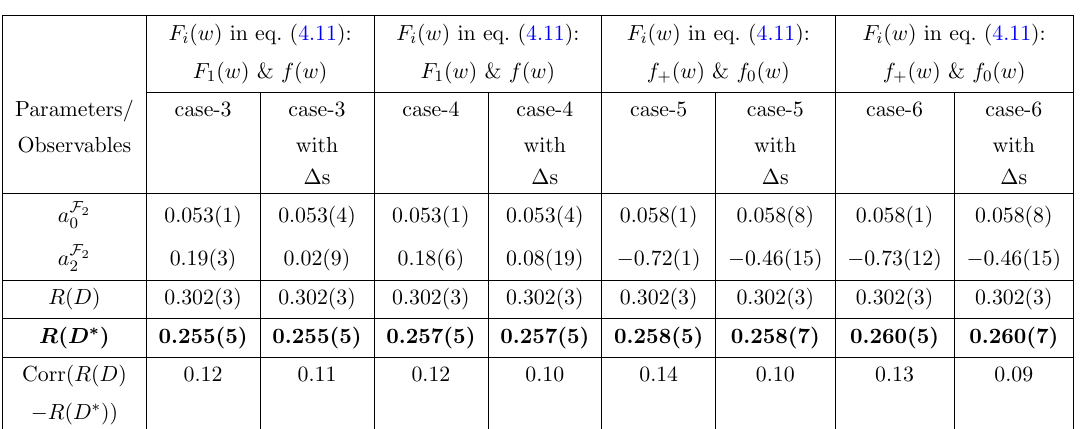
Table 16 . The predictions for R ( D ( (cid:3) ) ) using the (cid:12)t results of the HQET parameters given in table 14. a F 2 is (cid:12)xed using eq. (4.19). The additional error ((cid:1)) in the ratio h + =h A 1 considered as 1 (cid:6) 0 : 1 (for detail, see the text). Also, wherever applicable, the (cid:1) 31 , (cid:1) 21 and (cid:1) (cid:7) , they all are taken as 1 (cid:6) 0 : 2. The details of the choices of F i ( w ) in di(cid:11)erent cases can be seen from the text.